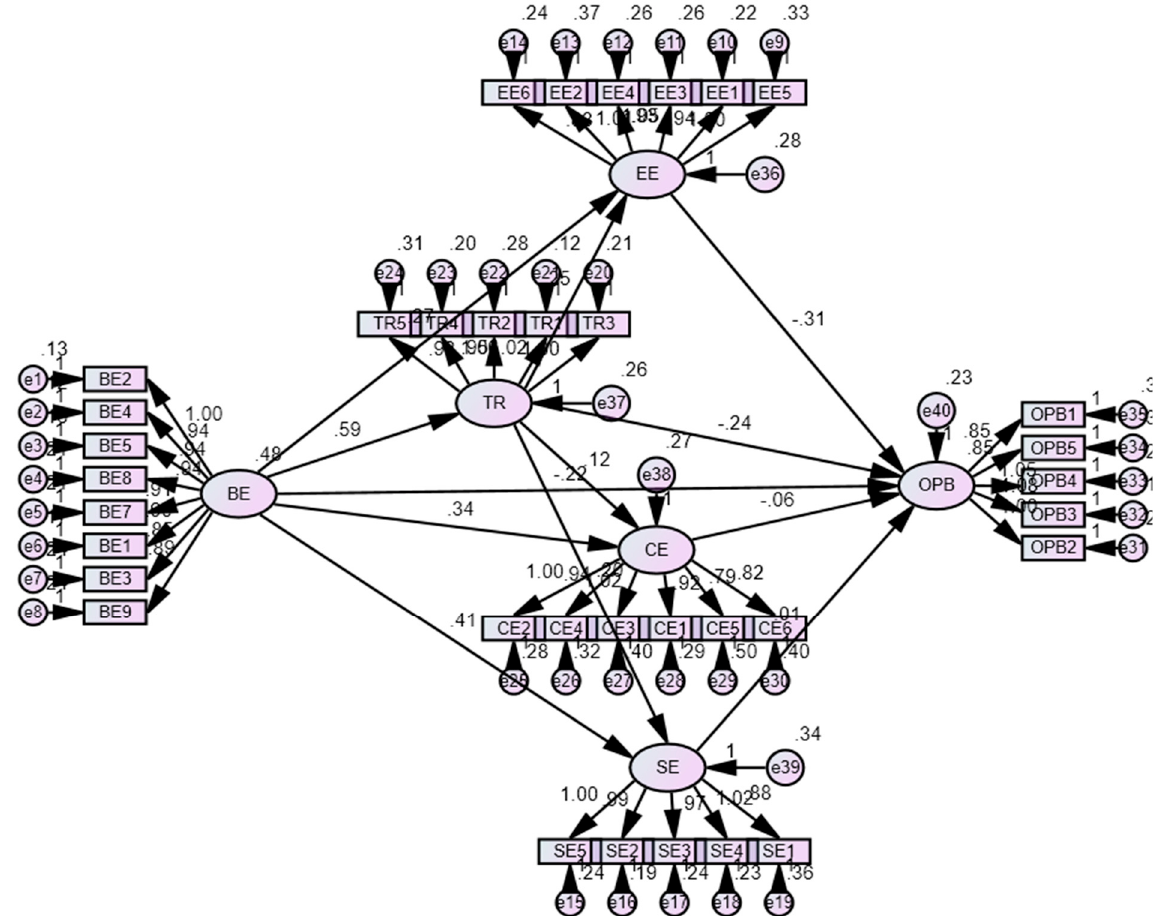
Figure 2. SEM model analysis.